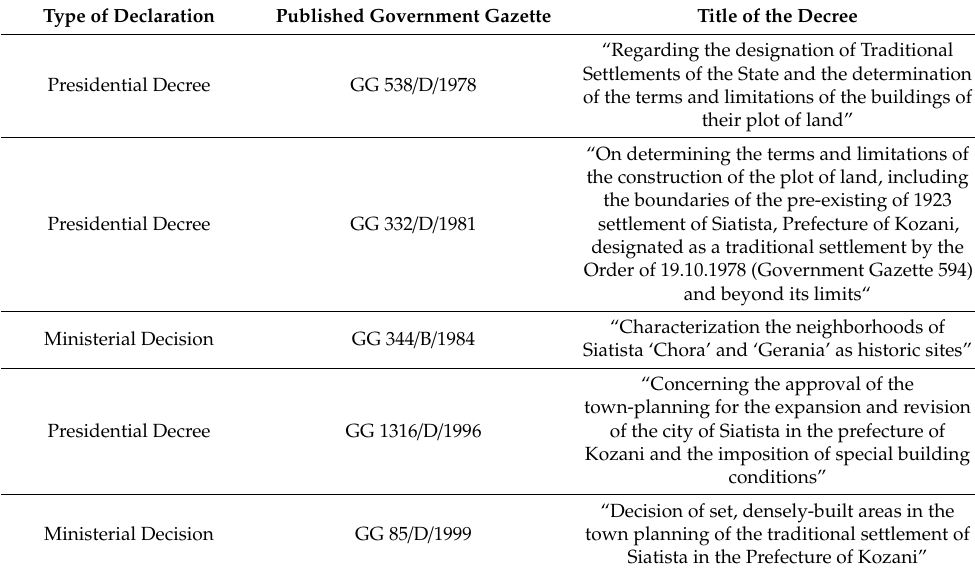
Table 1. Legal framework of Siatista Voios